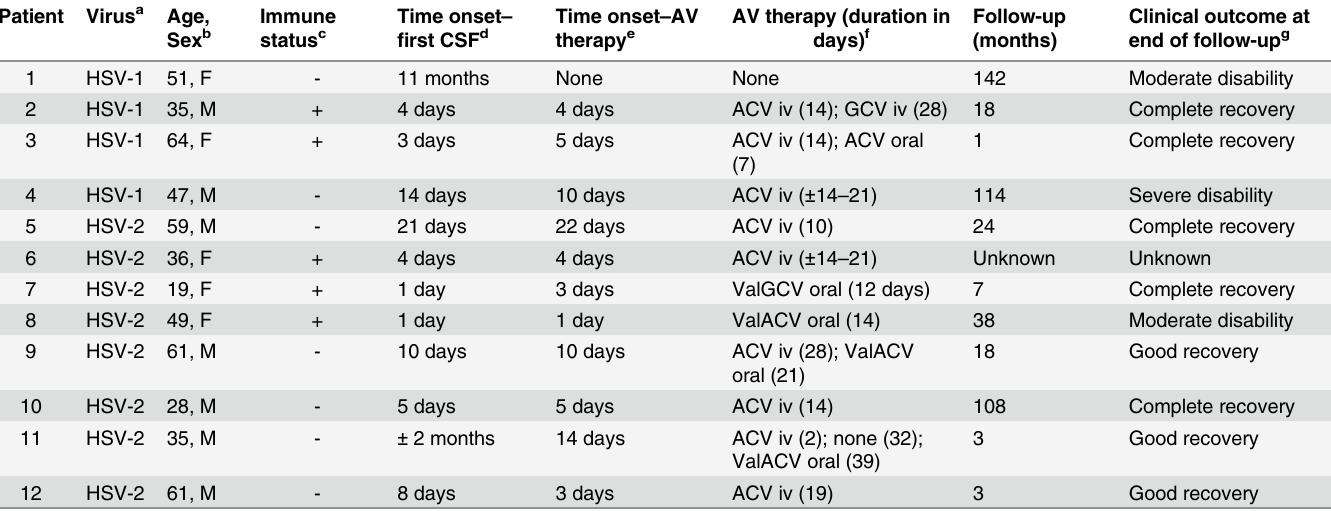
Table 1. Demographics and clinical characteristics of herpes simplex encephalitis